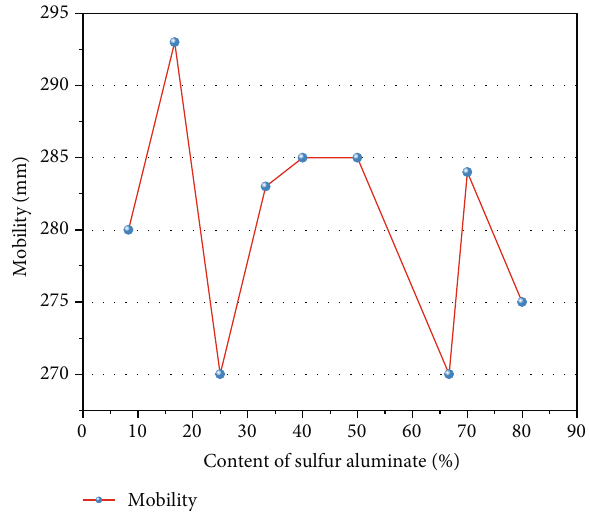
Figure 11: E ff ect of di ff erent dosages of sulfoaluminate cement on fl uidity.